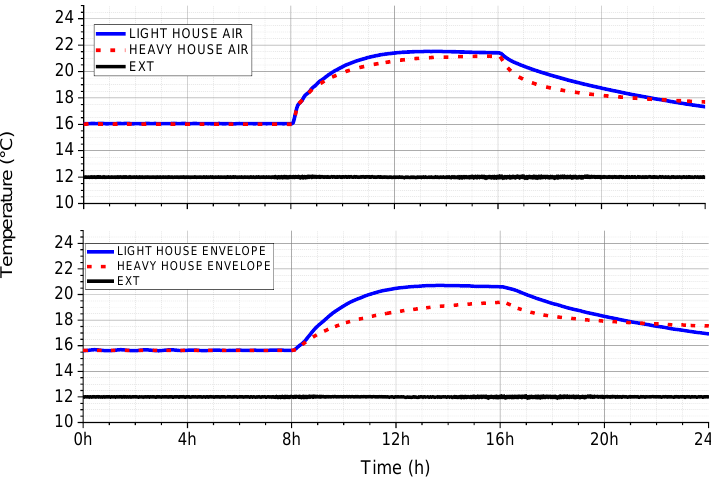
Figure 20. Experimental temperature evolution in the test chamber (upper: mean air temperature, bottom: mean envelope temperature).